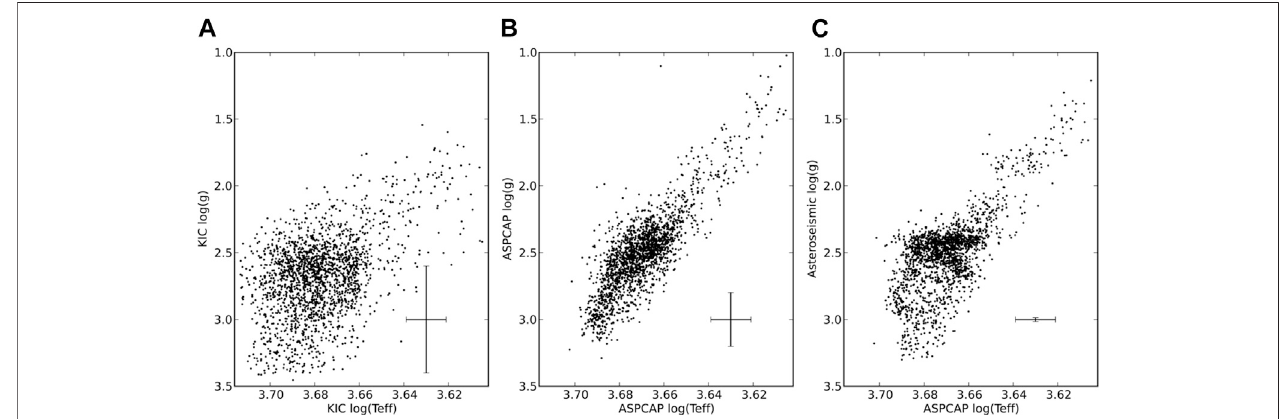
FIGURE 5 | Evolved APOKASC catalog stars plotted from different sources. The left panel are parameters from the photometric Kepler Input Catalog. The middle panel uses APOGEE ’ s pipeline-derived spectroscopic values. The right panel uses the more precise asteroseismic surface gravity. The red clump is signi fi cantly enhanced, as is the RGB bump. Median uncertainties are given by the crosses in the lower part of each panel. From Pinsonneault et al. (Pinsonneault et al.,